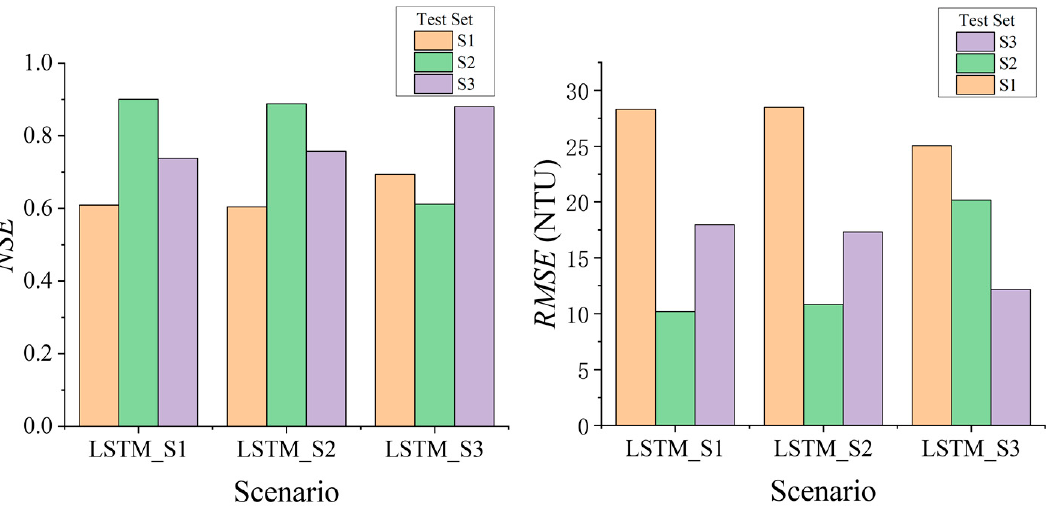
Figure 8. ( Left ) NSE and ( right ) RMSE of the LSTM model with different training and testing data.